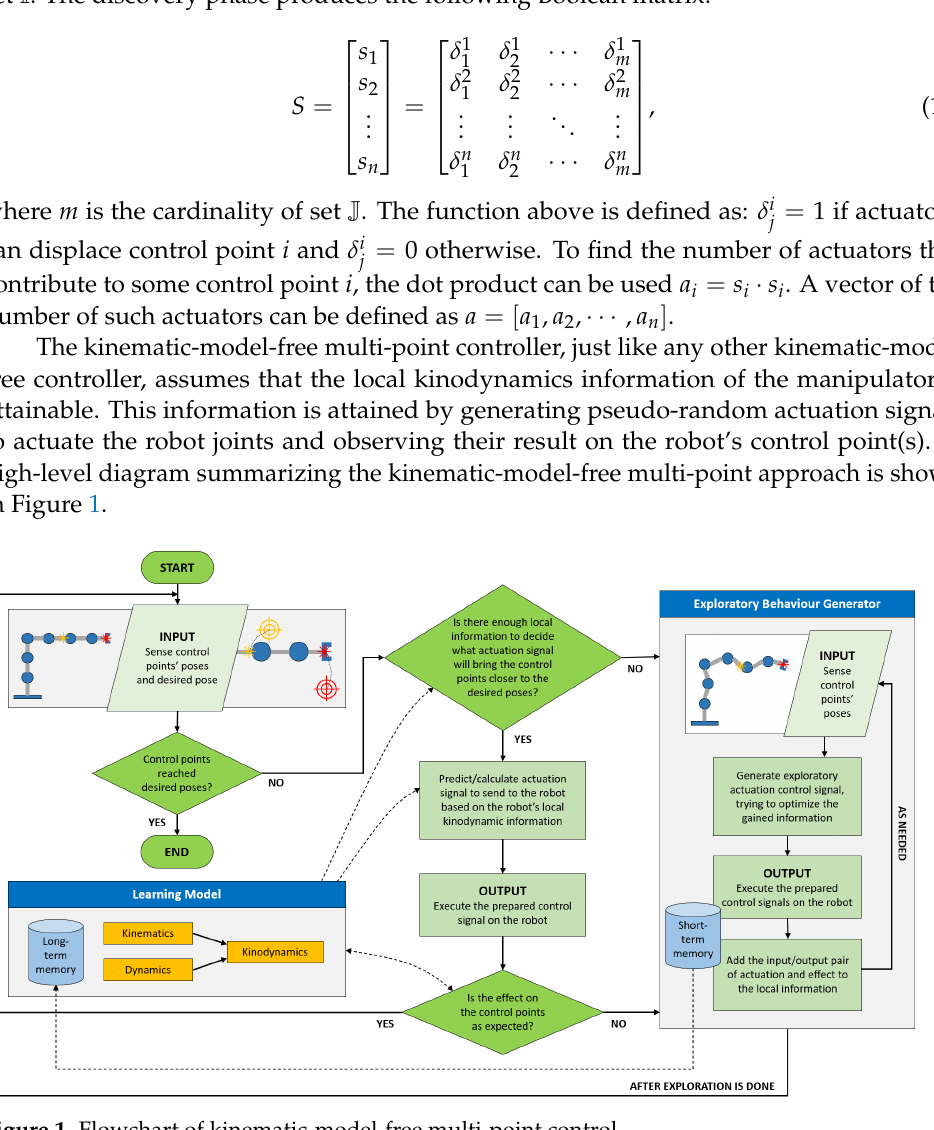
Figure 1. Flowchart of kinematic-model-free multi-point